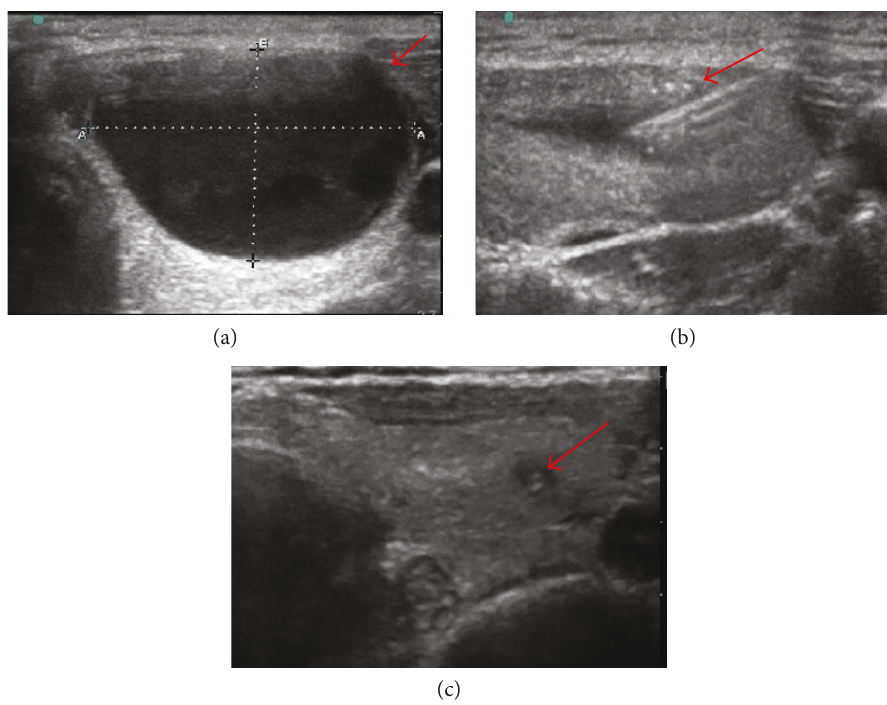
Figure 1: Ultrasonographic images of a 23-year-old woman before, during, and after treatment: (a) a cystic thyroid nodule of ultrasonographic images before PPI treatment; (b) during PPI treatment; (c) 12 months after PPI treatment; the nodule decreased signi fi cantly (arrow). PPI: percutaneous polidocanol